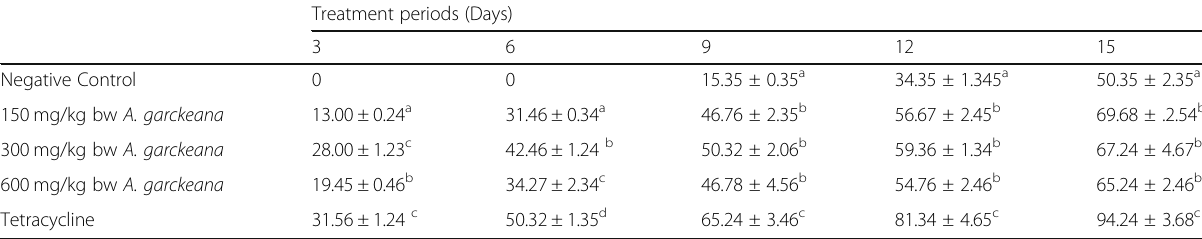
Table 10 Percentage wound contraction in rats post infliction of excision